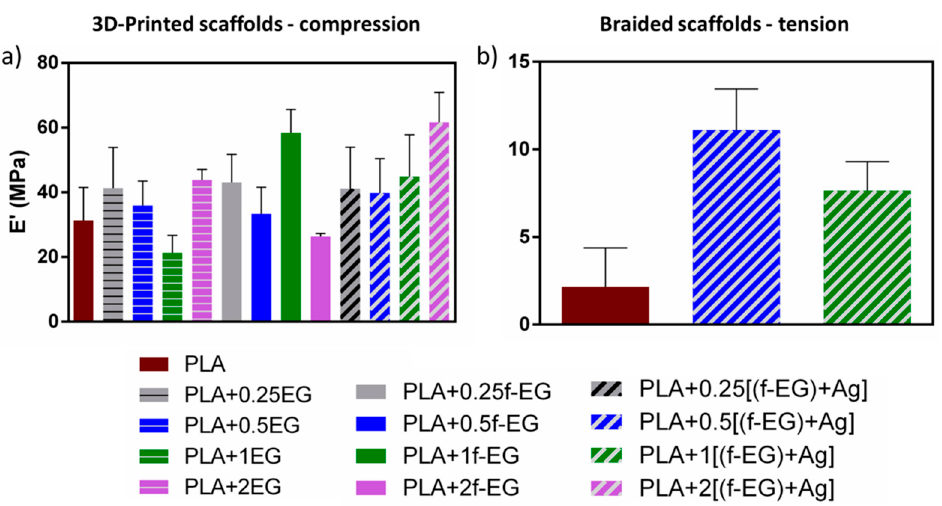
Figure 12. DMA results for the E ′ of ( a ) 3D-printed (under compression) and ( b ) braided scaffolds (under tension) at 37 °C and 1 Hz.